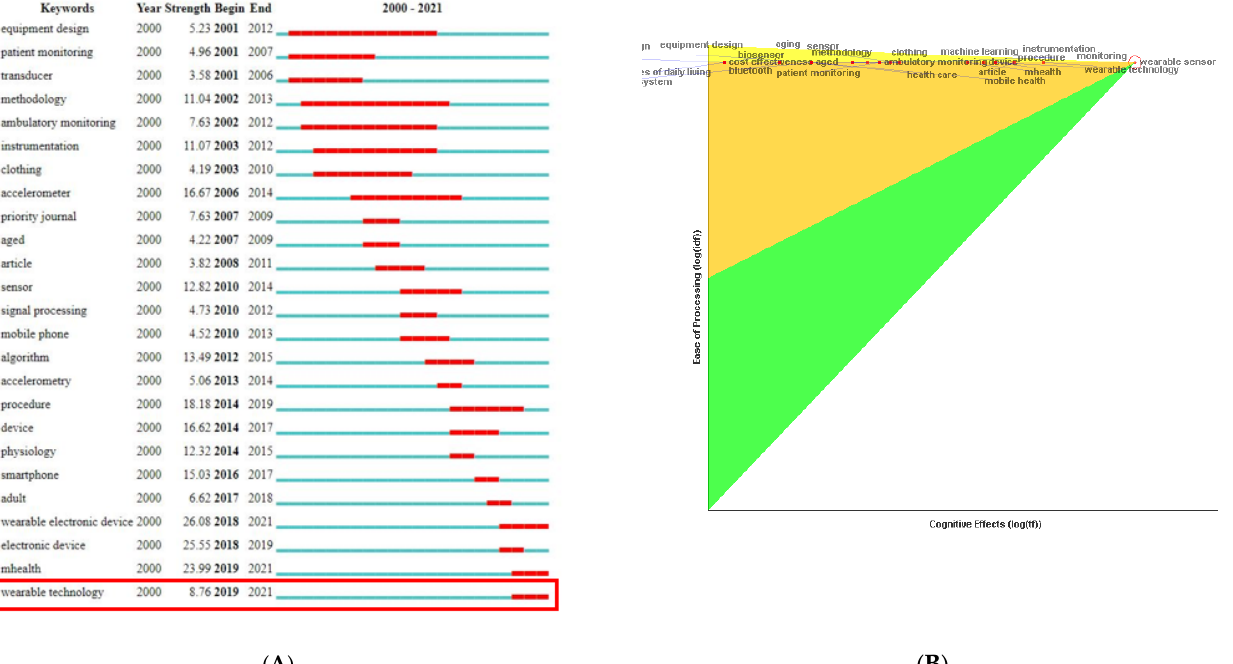
Figure 9. ( A ) Visualization of the history of the burstiness of keywords in publications on WTH (2000–2021 **). Wearable Technology, for example, has the longest burst period from 2019 to 2021**. ( B ) Pennant chart of concepts related to the term “wearable technology”. ** Data retrieval for this research was carried out at the end of the year 202c1.